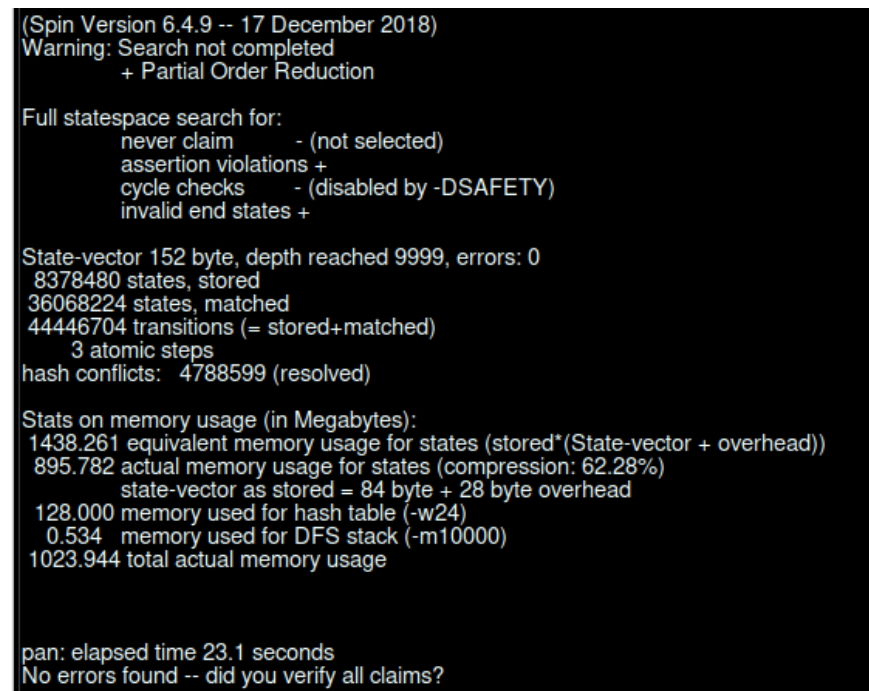
Figure 17. SPIN verification for interaction between LIdP and different devices.